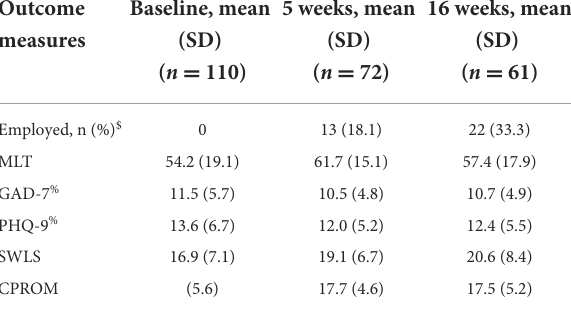
TABLE 2 Mean scores of outcomes measures at baseline, 5 and 16 weeks.